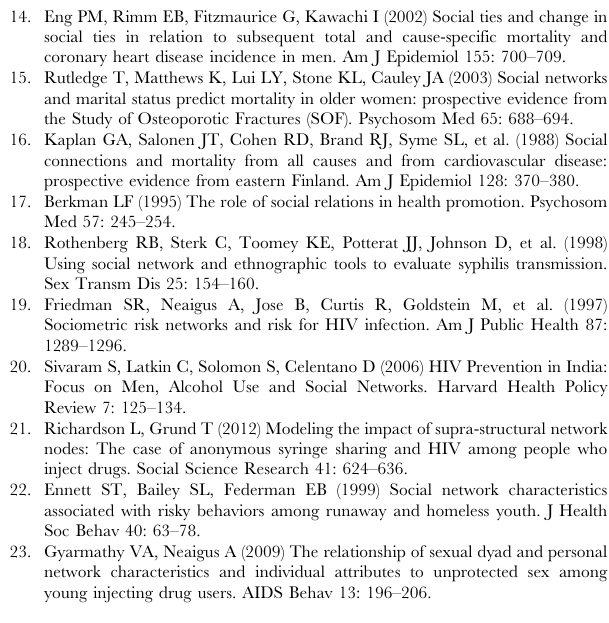
Table S1 Characteristics of respondents, by